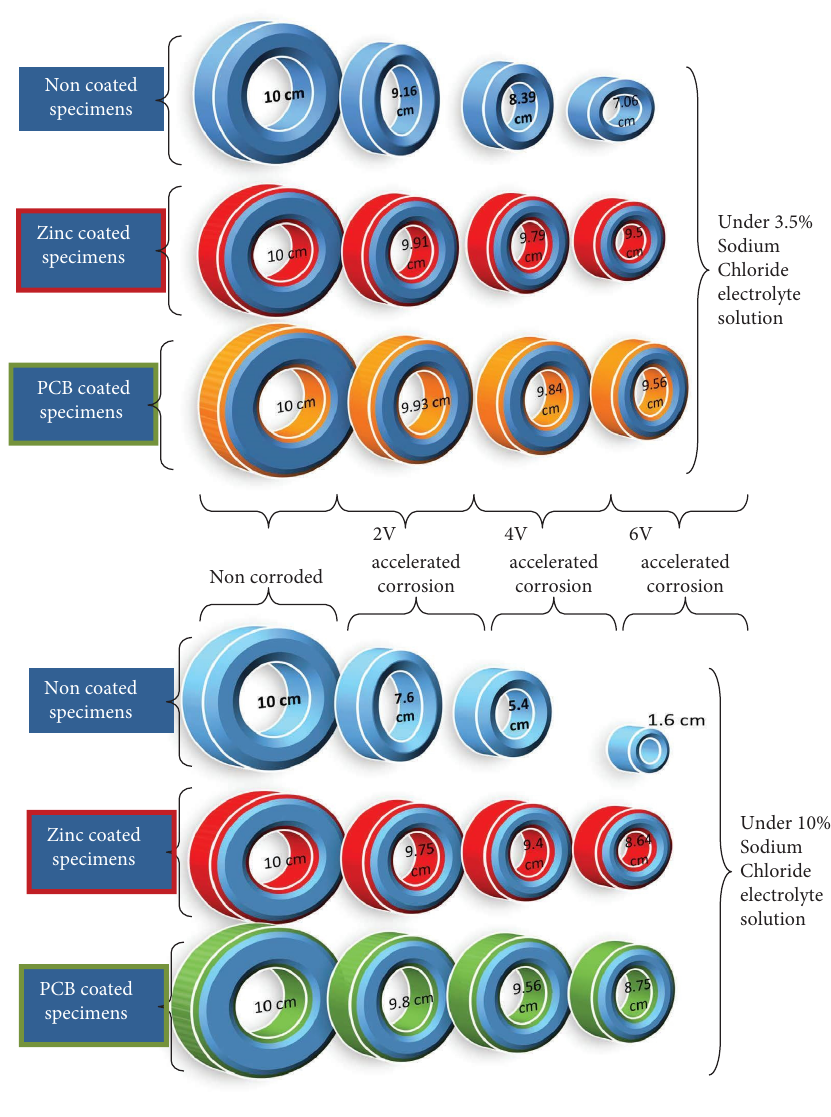
Figure 8: Comparison of change in diameter of the